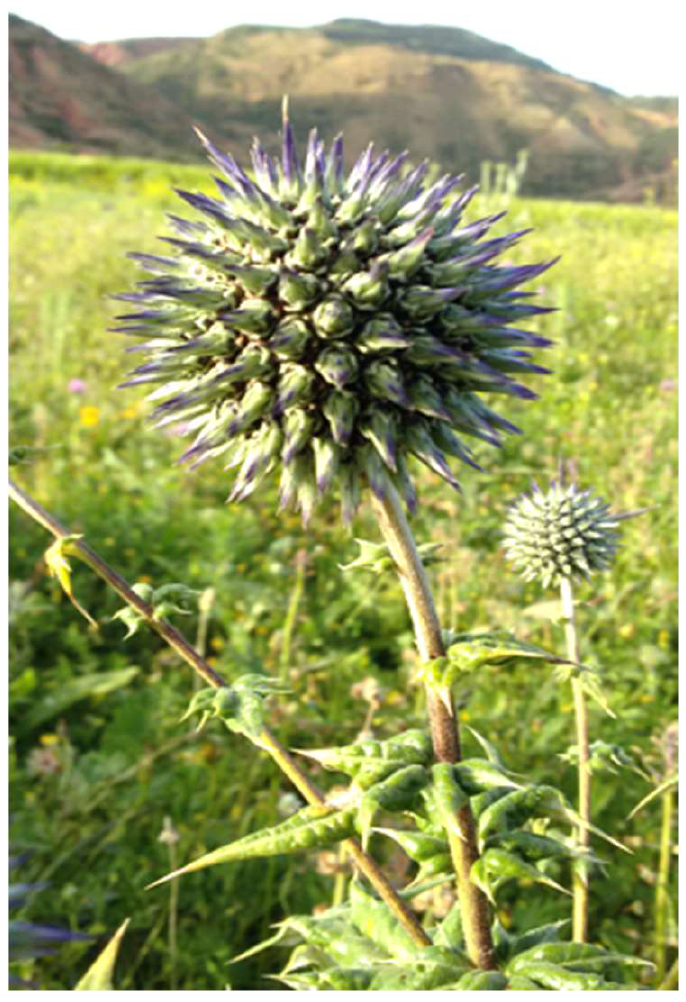
Figure 5 . Echinops spinosissimus Turra (Sidi Belattar Mostaganem, 2018). Figure 5. Echinops spinosissimus Turra (Sidi Belattar Mostaganem,